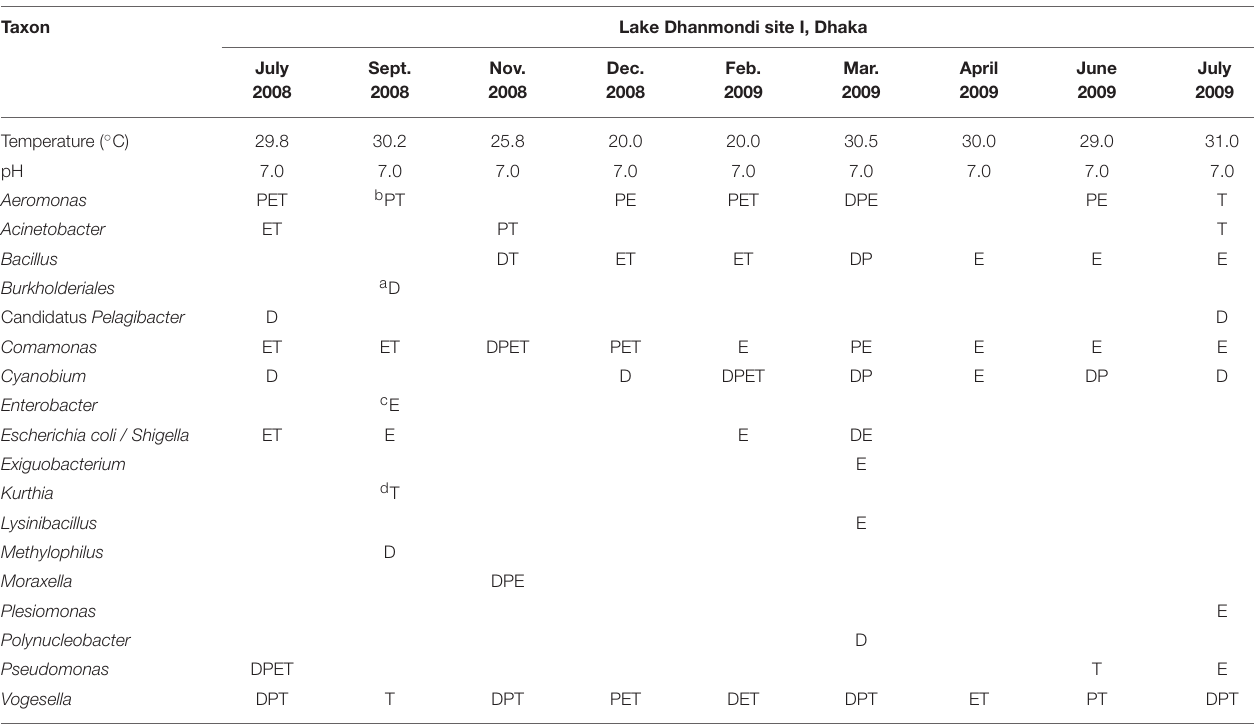
TABLE 2 | Distribution of bacterial genera in Lake Dhanmondi site I in July 2008–2009.